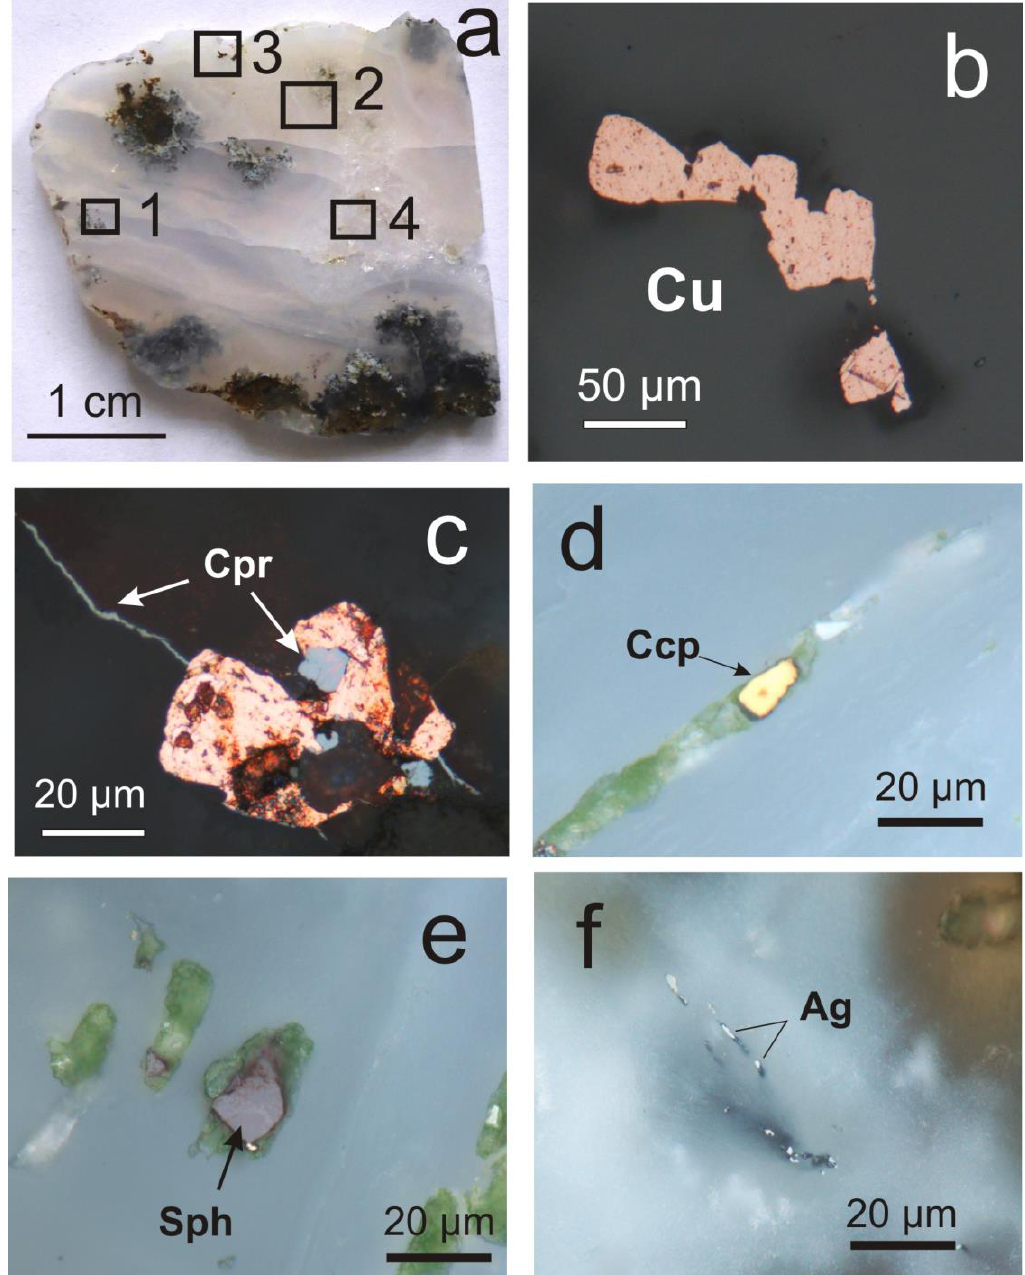
Figure 8. Macrophotograph of the agate No. 8 ( a ) and ore minerals in it ( b – f ): ( b ) dendrites of native copper; ( c ) cuprite (Cpr) (veins and inclusions) in intergrowth with native copper (Cu) among fine-grained quartz; ( d ) chalcopyrite (Ccp) in a cavity in a pseudomorphs of quartz (Figure 9d); ( e ) sphalerite (Sph); ( f ) native silver (Ag). ( b – f ) micrographs in reflected light. Squares 1 – 4 are RS research areas.